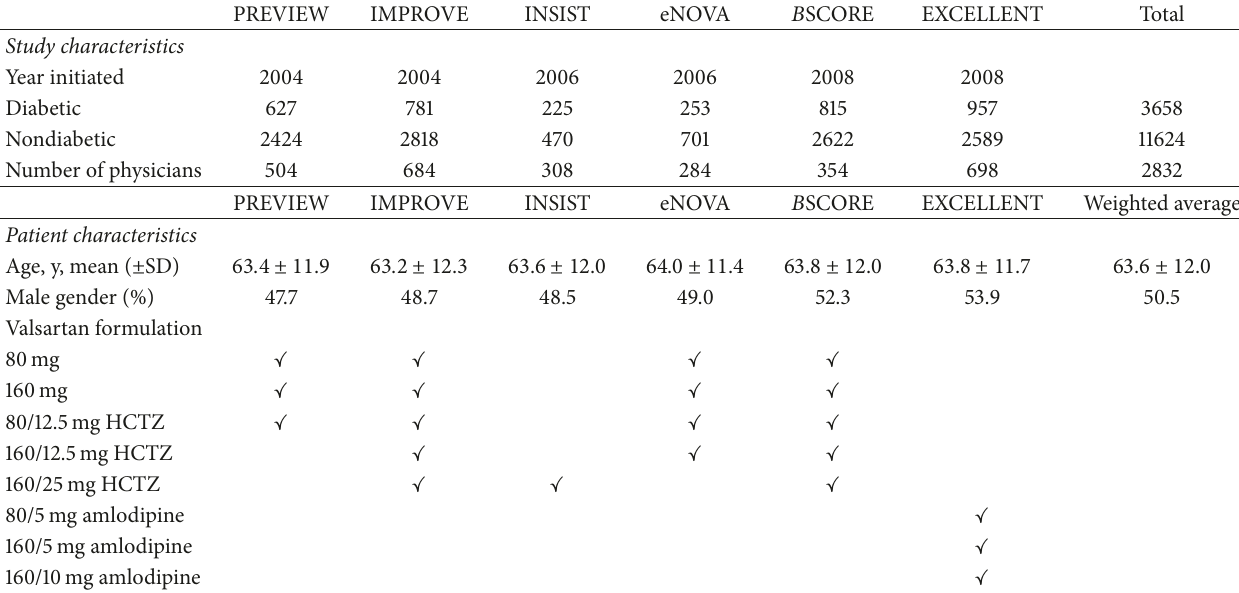
Table 1: Studies included in pooled